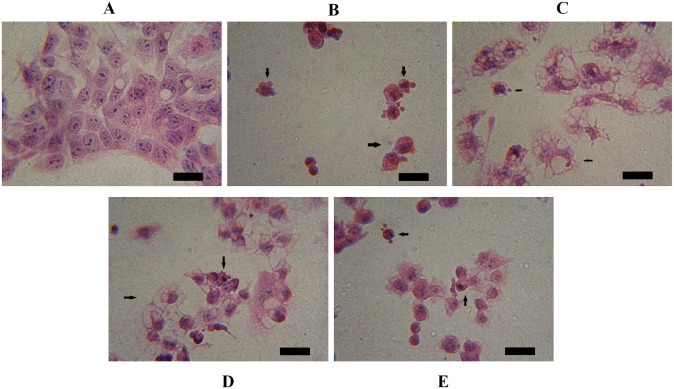
Effects of 1,3,4-thiadiazolium derivatives on HepG2 cell morphology (the experimental conditions are described in the Materials and Methods section 2.6).The cells were seeded with or without 1,3,4-thiadiazolium derivatives at 5 μM for 3 h. The images were captured with a 100X magnification; they correspond to control (A), MI-D (B), MI-J (C), MI-4F (D) and MI-2,4diF (E). The scale is indicated by black bars representing 0.02 mm. The arrows show morphological modifications as blebs, increased volume and vacuolization. The photographs represent three different experiments in triplicate.